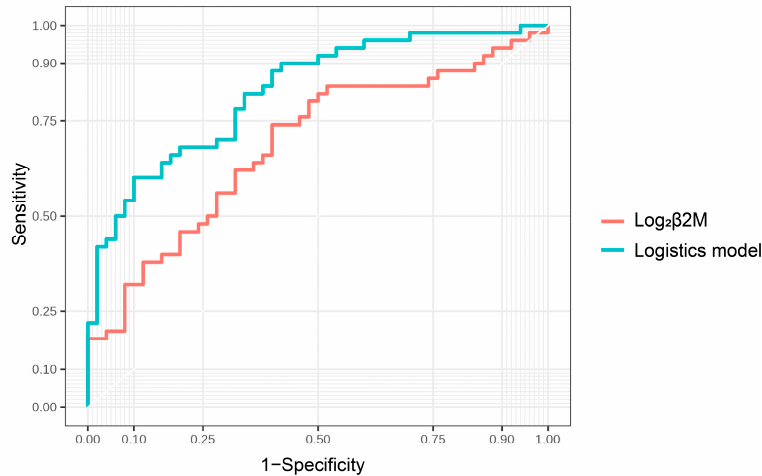
Figure 5. ROC curve analysis of the logistic regression model.